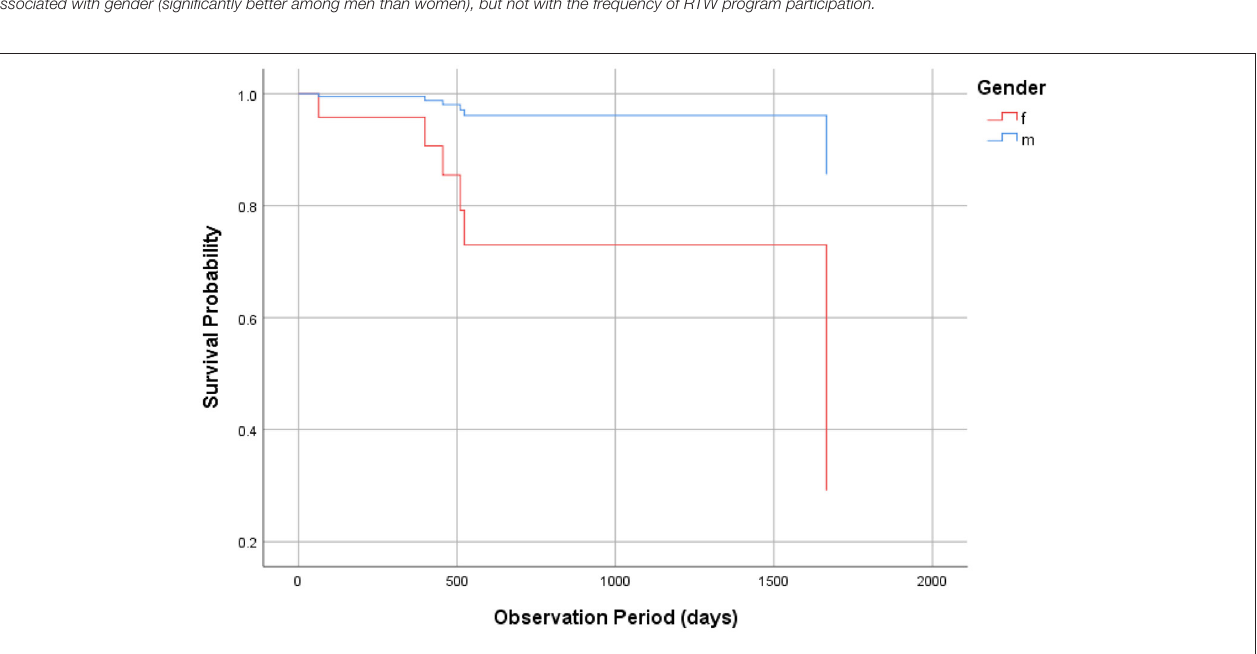
FIGURE 2 | Cox regression